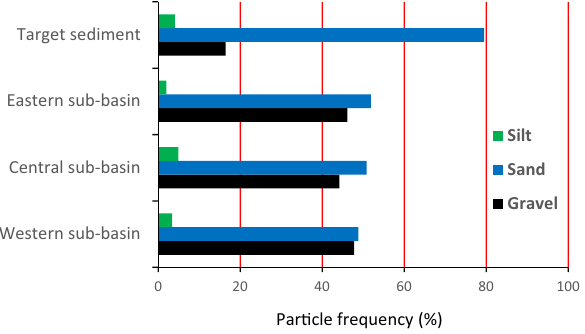
Figure 3. The mean of the particles size for three sources and target